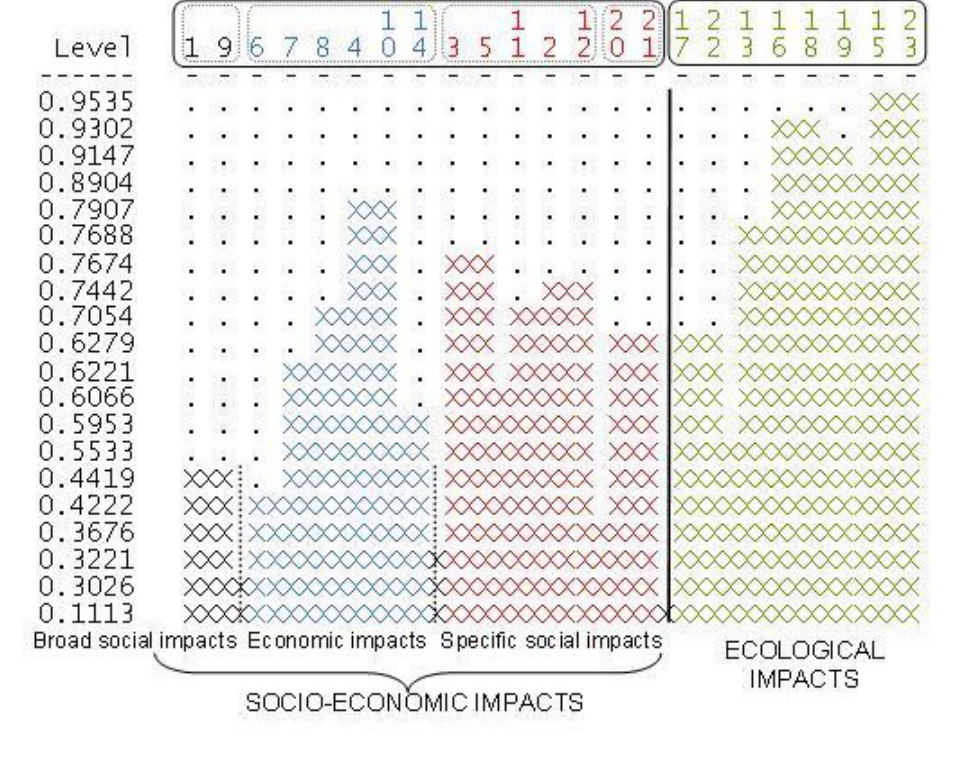
Fig. 9 . Hierarchical cluster analysis of the consequences of the river stopping flowing (‘Level’ is a measure of the relative distance between concept